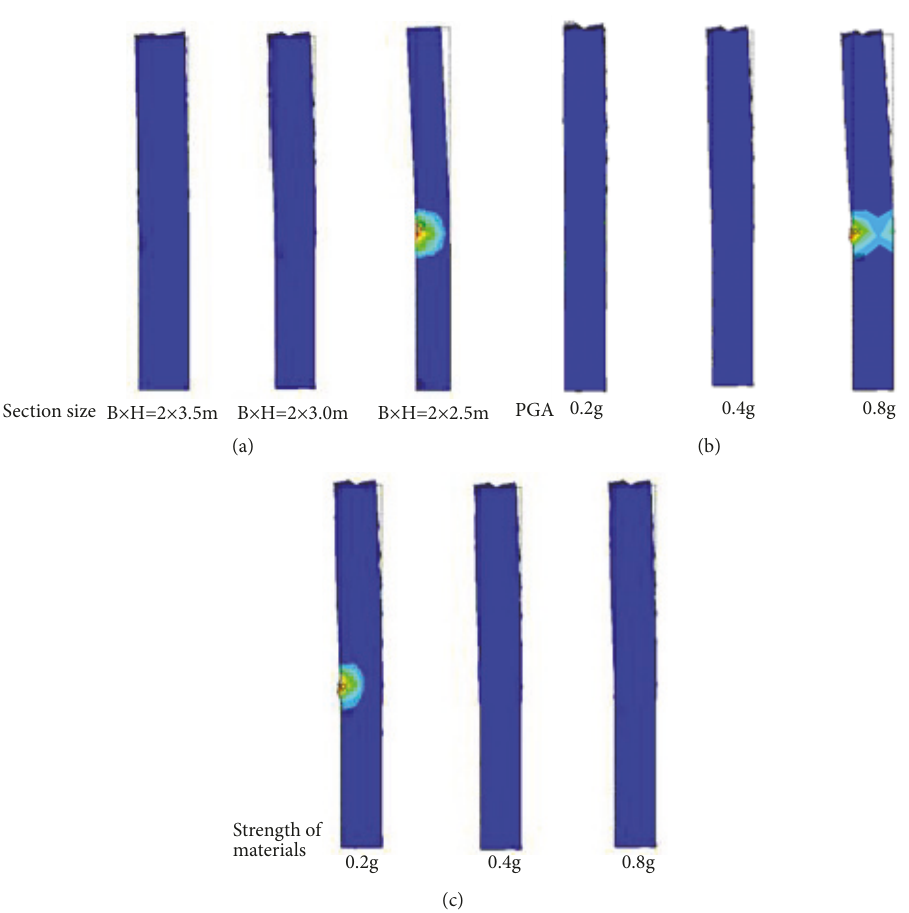
Figure 18: The plastic strain cloud diagram of stabilizing pile in different working conditions. (a) Different section sizes; (b) different PGAs; (c) different material